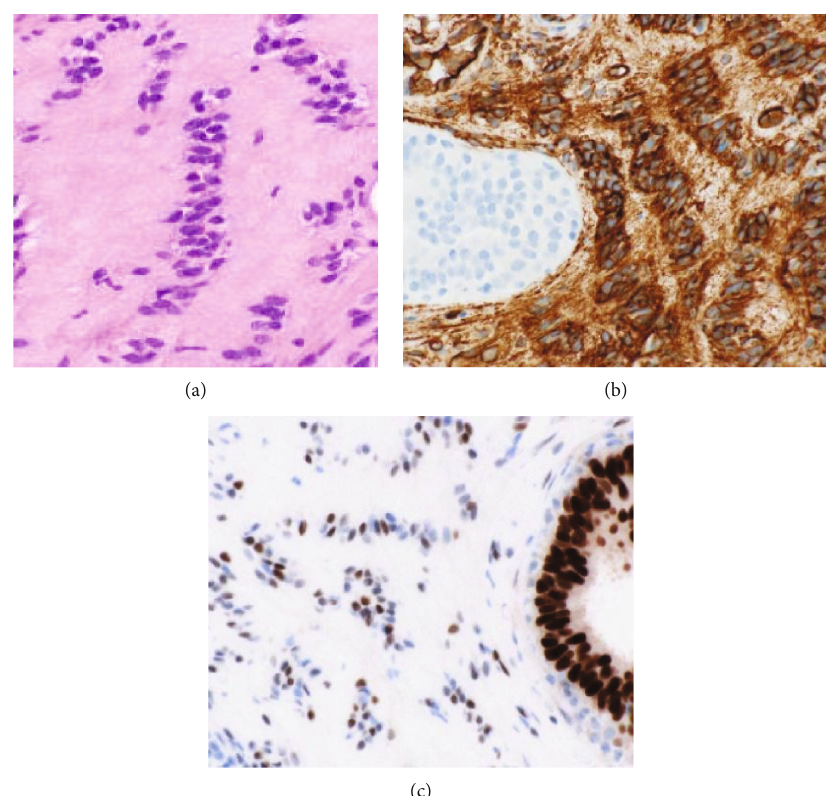
Figure 3: High-power histologic assessment con fi rming a zippered morphology with interlacing lesional nuclei oriented perpendicular to the cleft space ((a) hematoxylin and eosin, 400X). The lesional spindled cells demonstrate di ff use and strong immunoreactivity with CD34 while the adjacent epithelium is nonreactive ((b) CD34 IHC, 600X). The lesional spindled cells also show immunoreactivity with progesterone receptor ((c) PR IHC,